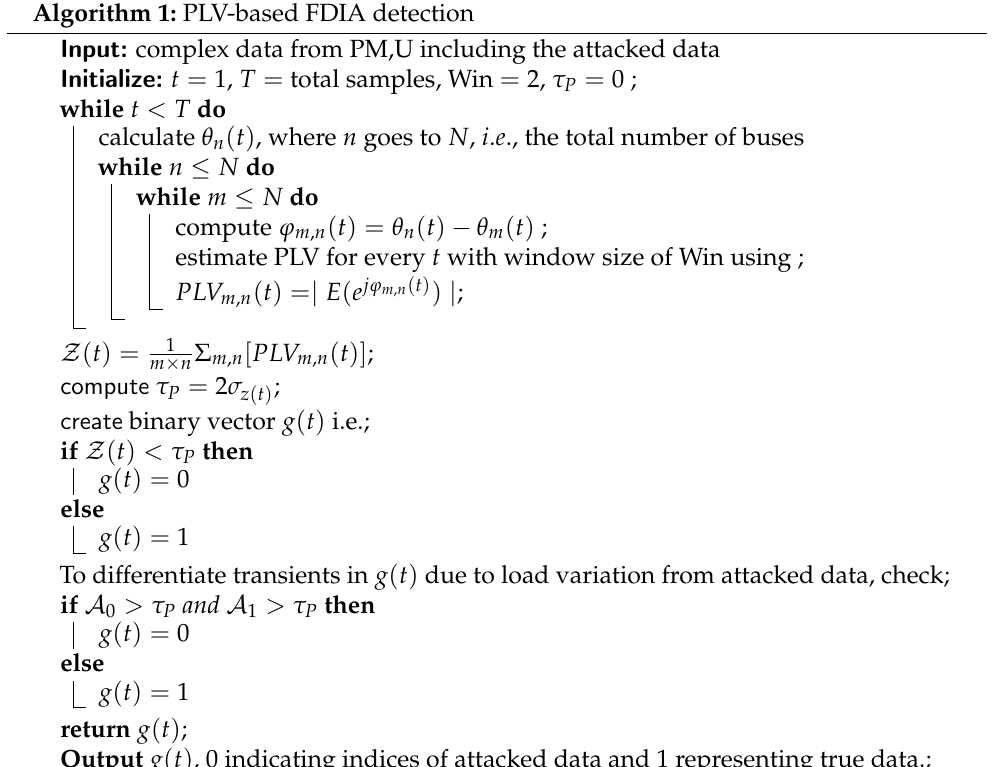
Algorithm 1: PLV-based FDIA